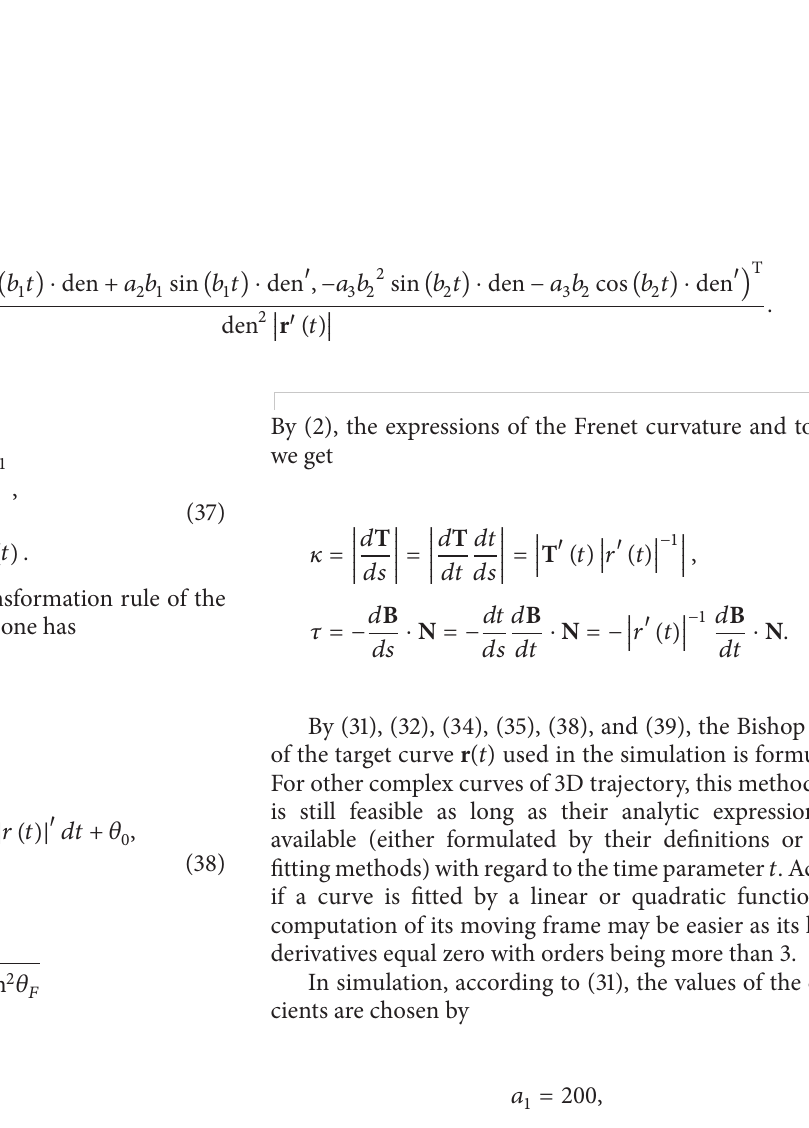
Figure 3: Simulation structure of the UAV flight control